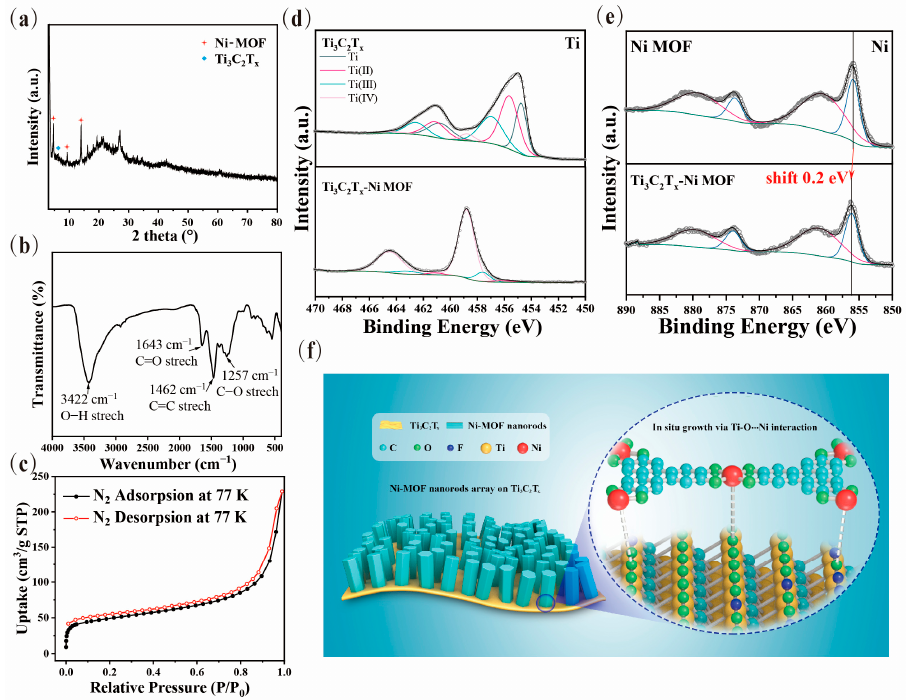
Figure 2. ( a ) XRD pattern, ( b ) FT-IR spectrum, and ( c ) BET curve of the Ni-MOF/Ti 3 C 2 T x sample; ( d , e ) XPS peaks of Ti and Ni elements in Ni-MOF/Ti 3 C 2 T x , respectively; and ( f ) the illustration of Ti-O ··· Ni interaction between Ni-MOF and Ti 3 C 2 T x .